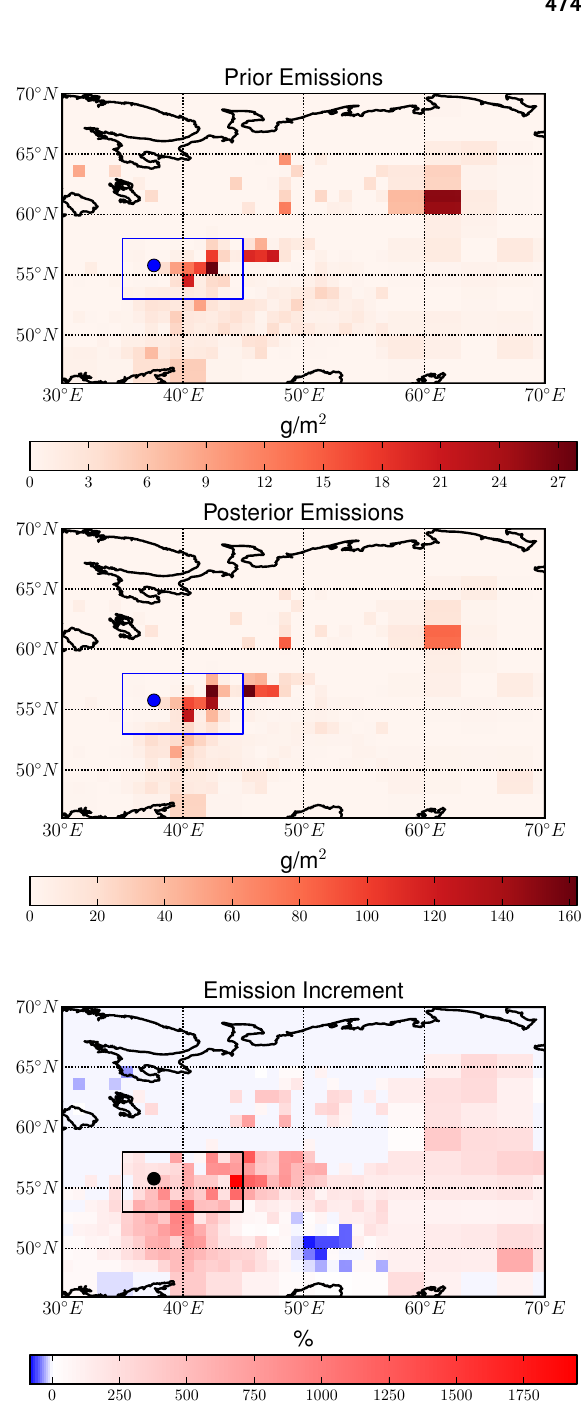
Fig. 3. Prior emissions (upper panel), posterior emissions (middle panel) and emission increment (lower panel) for the base inversion with MERGED emissions (see Table 1). Emissions and increments are based on the period 16 July 2010 up to 17 August 2010. The inset region is called R1 in Table 1 while the entire displayed region is referred to as R2. Note that a zoom region with higher resolution is present around Moscow